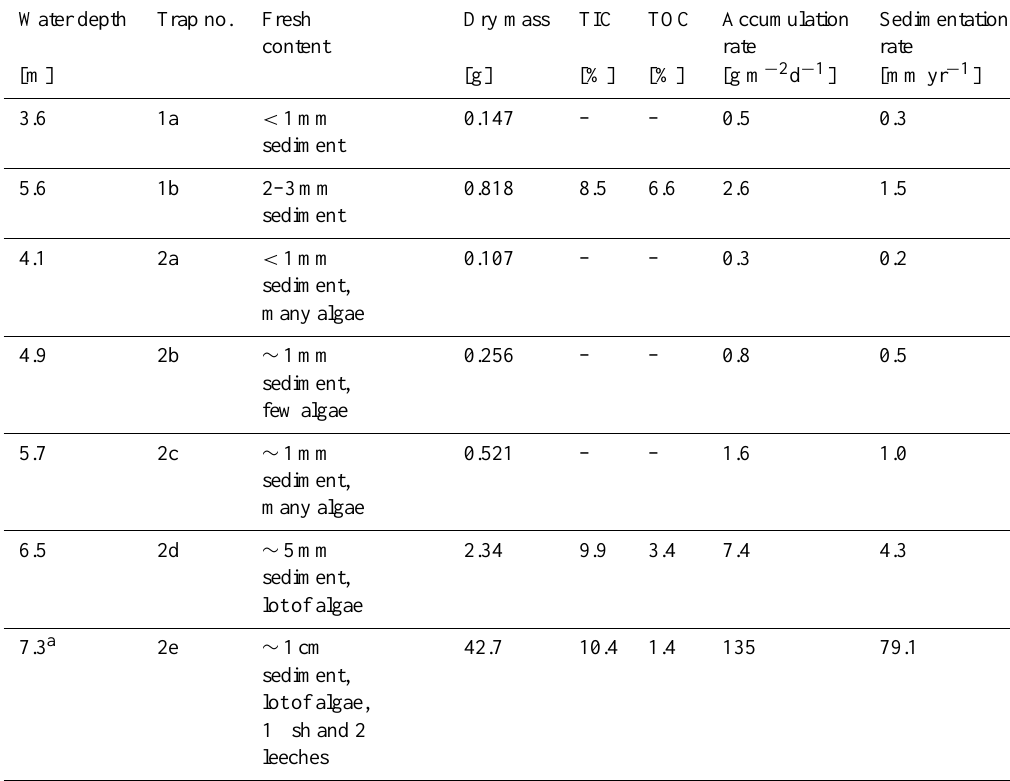
Table 2. Sediment trap analysis: Dry mass, TIC and TOC contents, mass accumulation and sedimentation rates for various depths. The trap numbers refer to moorings 1 and 2 (Fig. 3).